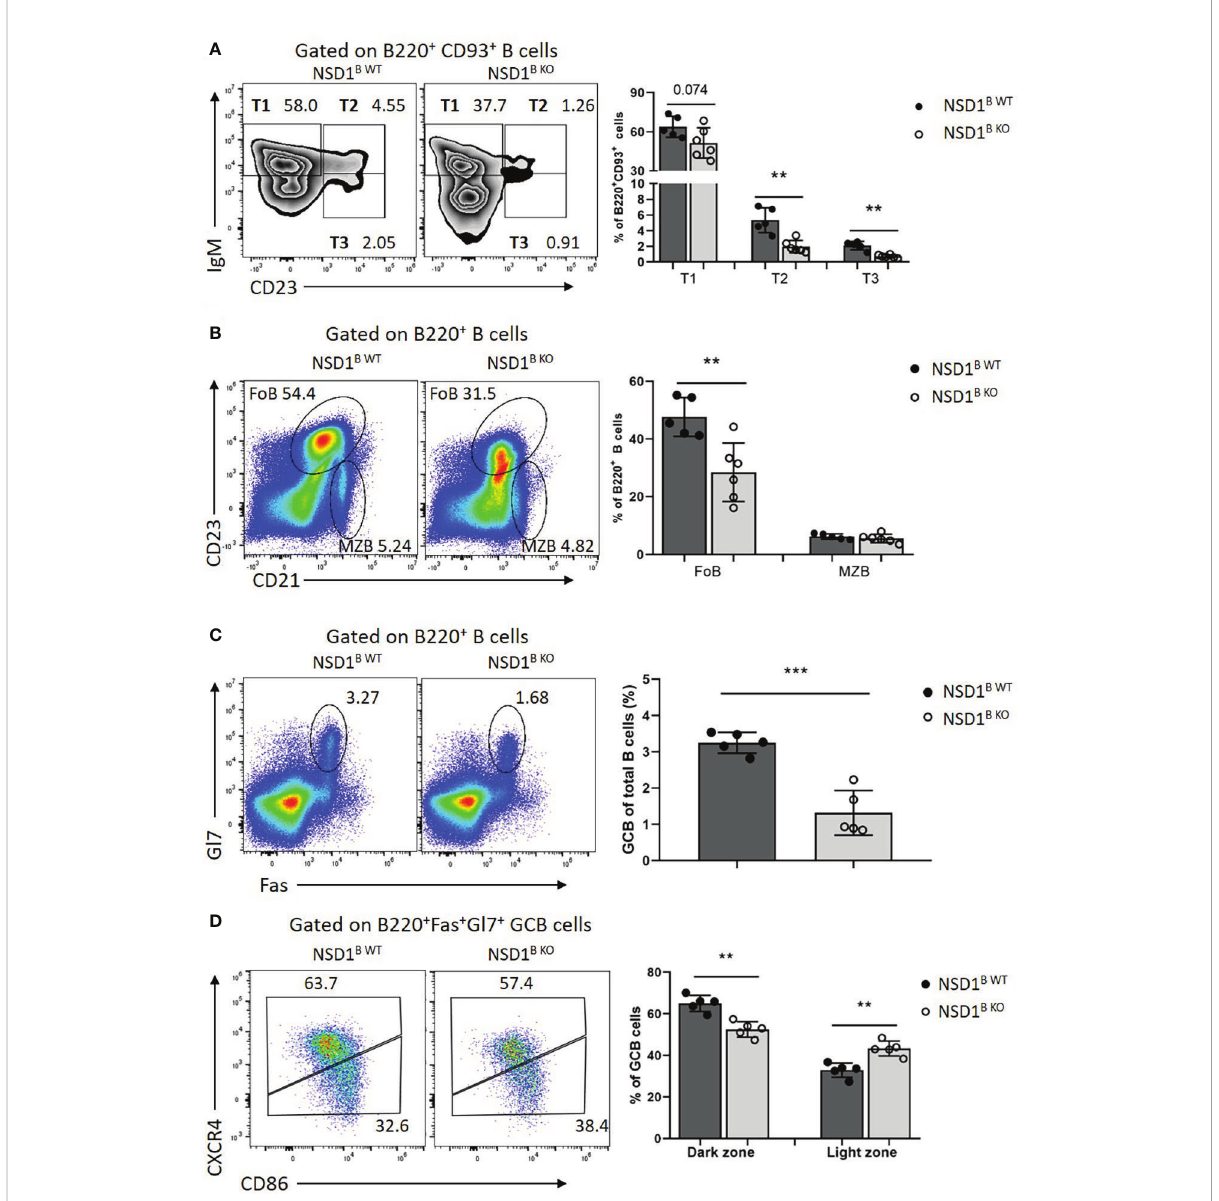
FIGURE 2 NSD1 is involved in the development of B cells and GC formation in spleen (A) . T1 (B220 + CD93 + IgM high CD23 - ), T2 (B220 + CD93 + IgM high CD23 + ) and T3 (B220 + CD93 + IgM low CD23 + ) in the spleen from NSD1 B WT and NSD1 B KO mice. (B) . The distribution of follicular B (FOB, B220 + CD23 + CD21 low ) cell and marginal zone B (MZB, B220 + CD23 - CD21 high ) cell in the spleen from NSD1 B WT and NSD1 B KO mice. (C) . Germinal center B (B220 + Gl7 + Fas + ) cells in the spleen from NSD1 B WT and NSD1 B KO mice 7 days after SRBCs immunization. (D) . The dark zone (DZ, CXCR4 + CD86 - ) and light zone (LZ, CXCR4 - CD86 + ) GC B cells in the spleen from NSD1 B WT and NSD1 B KO mice 7days after SRBCs immunization. ** P < 0.01; *** P < 0.001. (n = 5 or